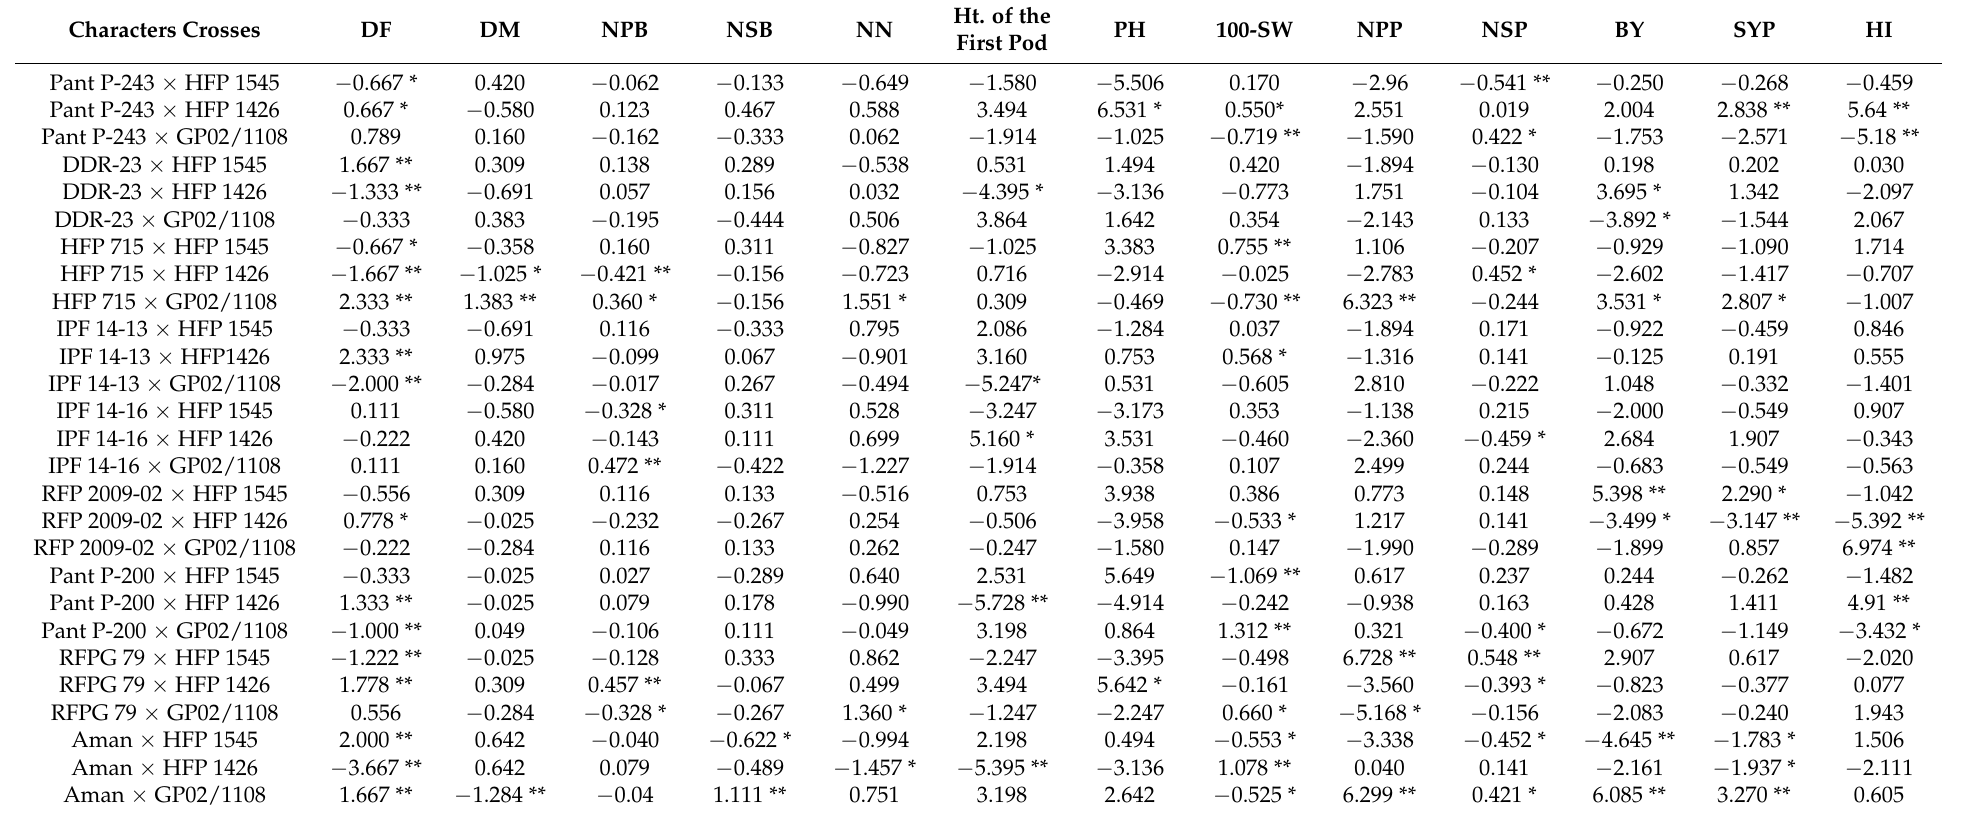
Table 4. SCA effects of different crosses for different characters in field